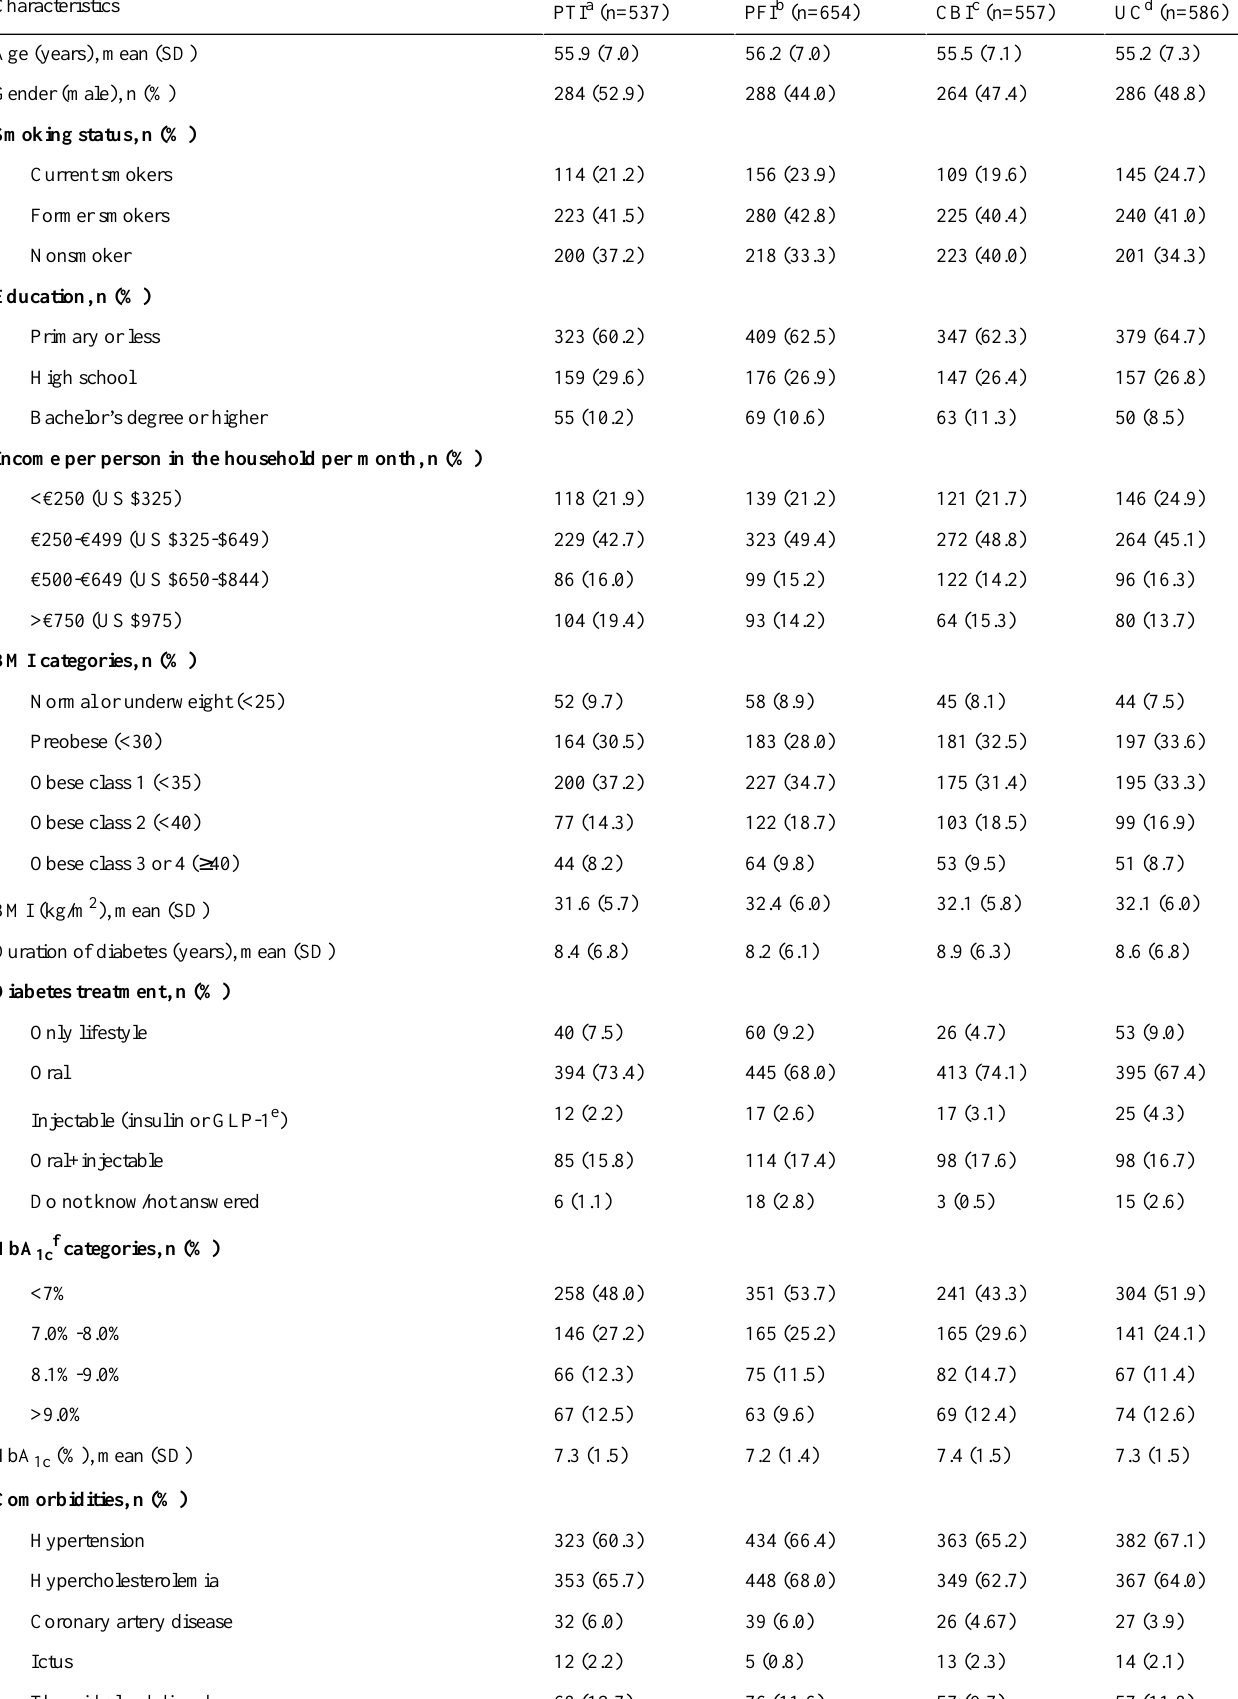
Table 1. Baseline characteristics of